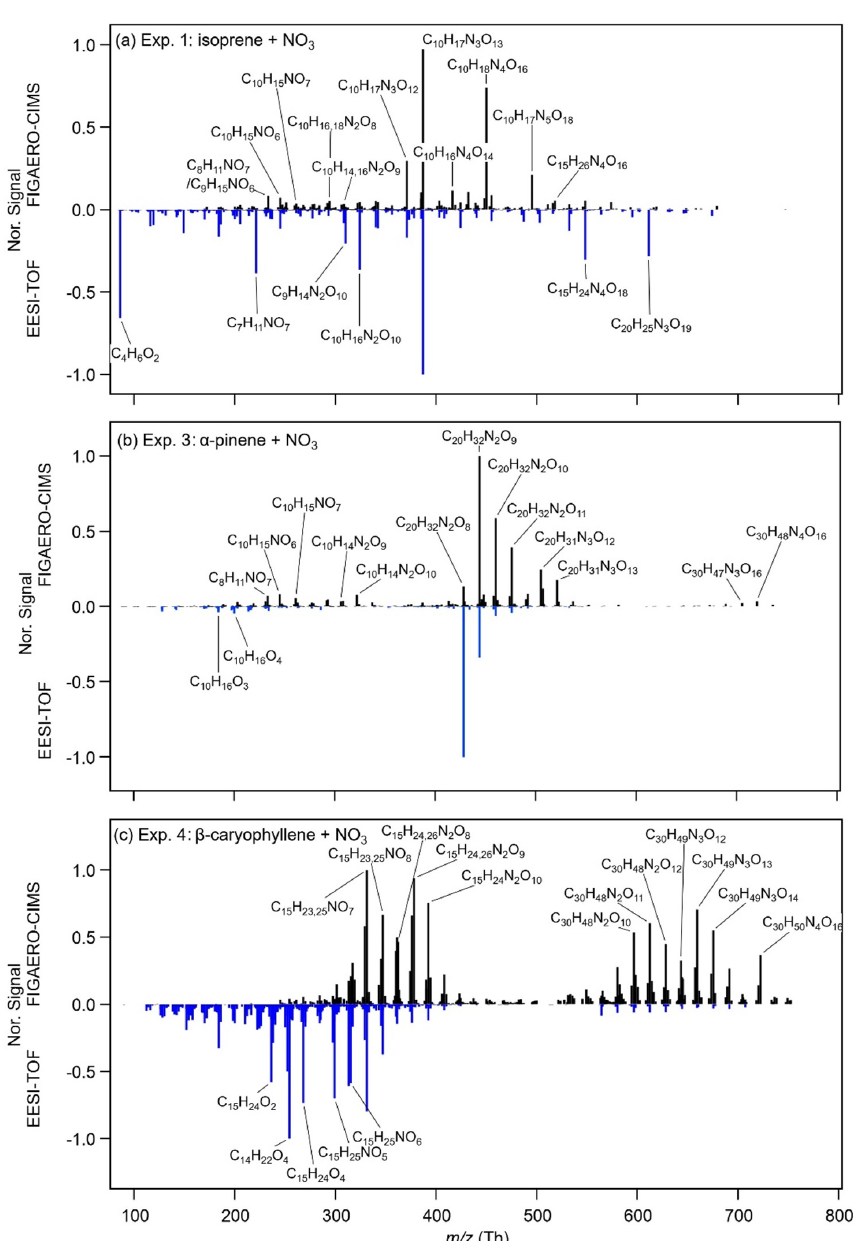
Figure 2. FIGAERO-CIMS (positive axis) and EESI-TOF (negative axis) mass spectra of particle-phase C x H y O z N 0–4 formed dur- ing (a) Exp. 1 (isoprene + NO 3 ), (b) Exp. 3 ( α -pinene + NO 3 ), and (c) Exp. 4 ( β -caryophyllene + NO 3 ) shortly before photolysis. For FIGAERO-CIMS, the last filter before photolysis is chosen (Pre 2 in Fig. 3). The EESI-TOF mass spectra are averaged mass spectra during the same sampling time as that of FIGAERO-CIMS. All mass spectra are normalized to the corresponding maximal signal.